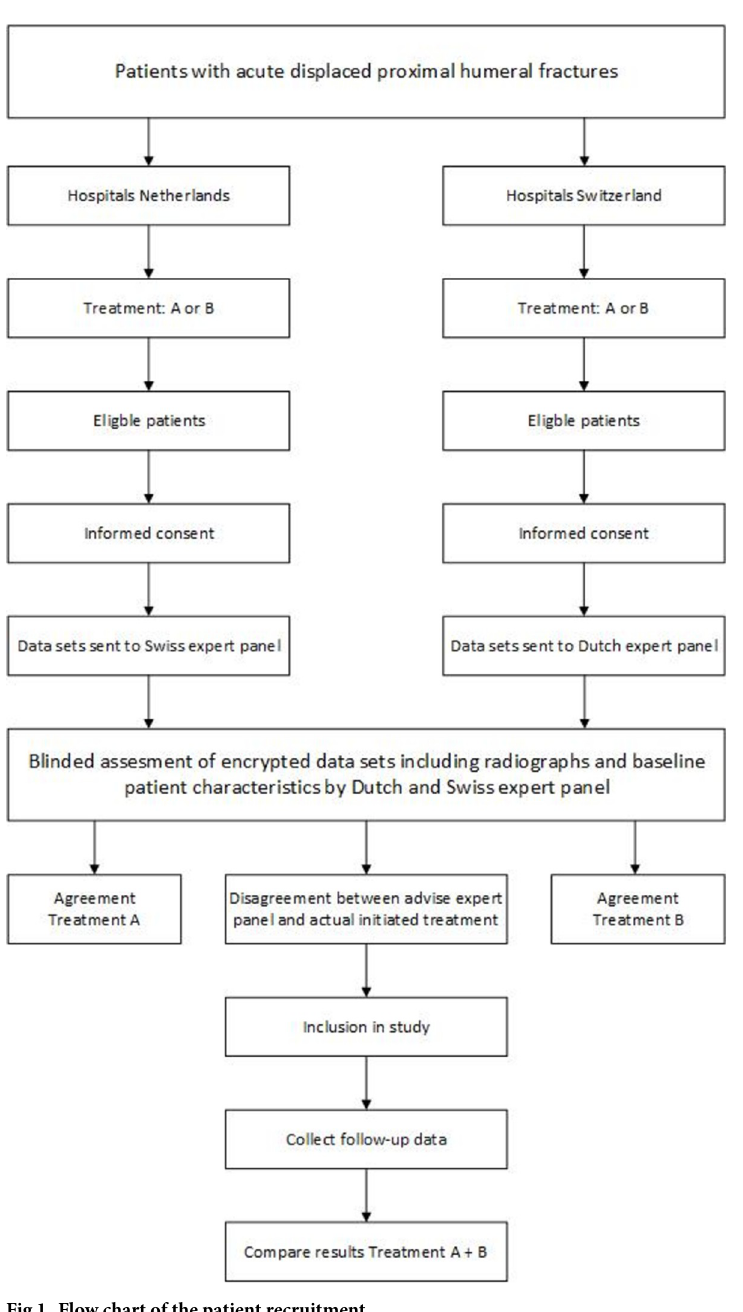
Fig 1. Flow chart of the patient